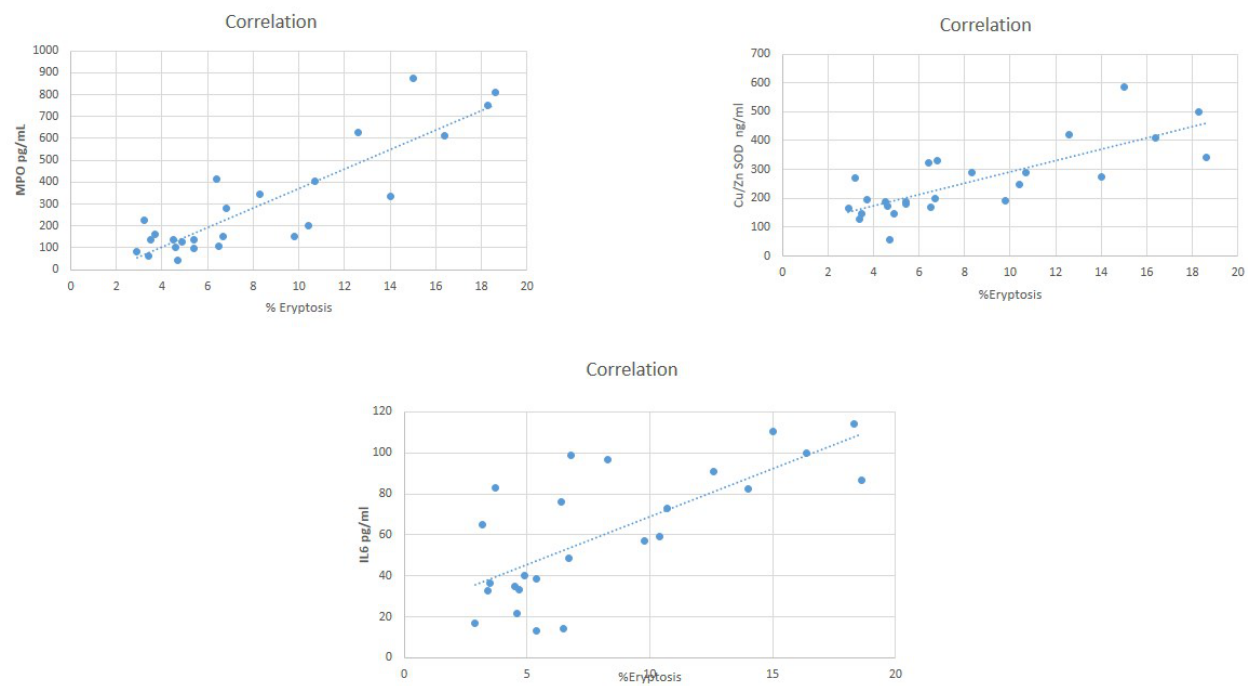
Figure 3. Correlation between MPO, CU/Zn SOD, IL-6 and eryptosis.